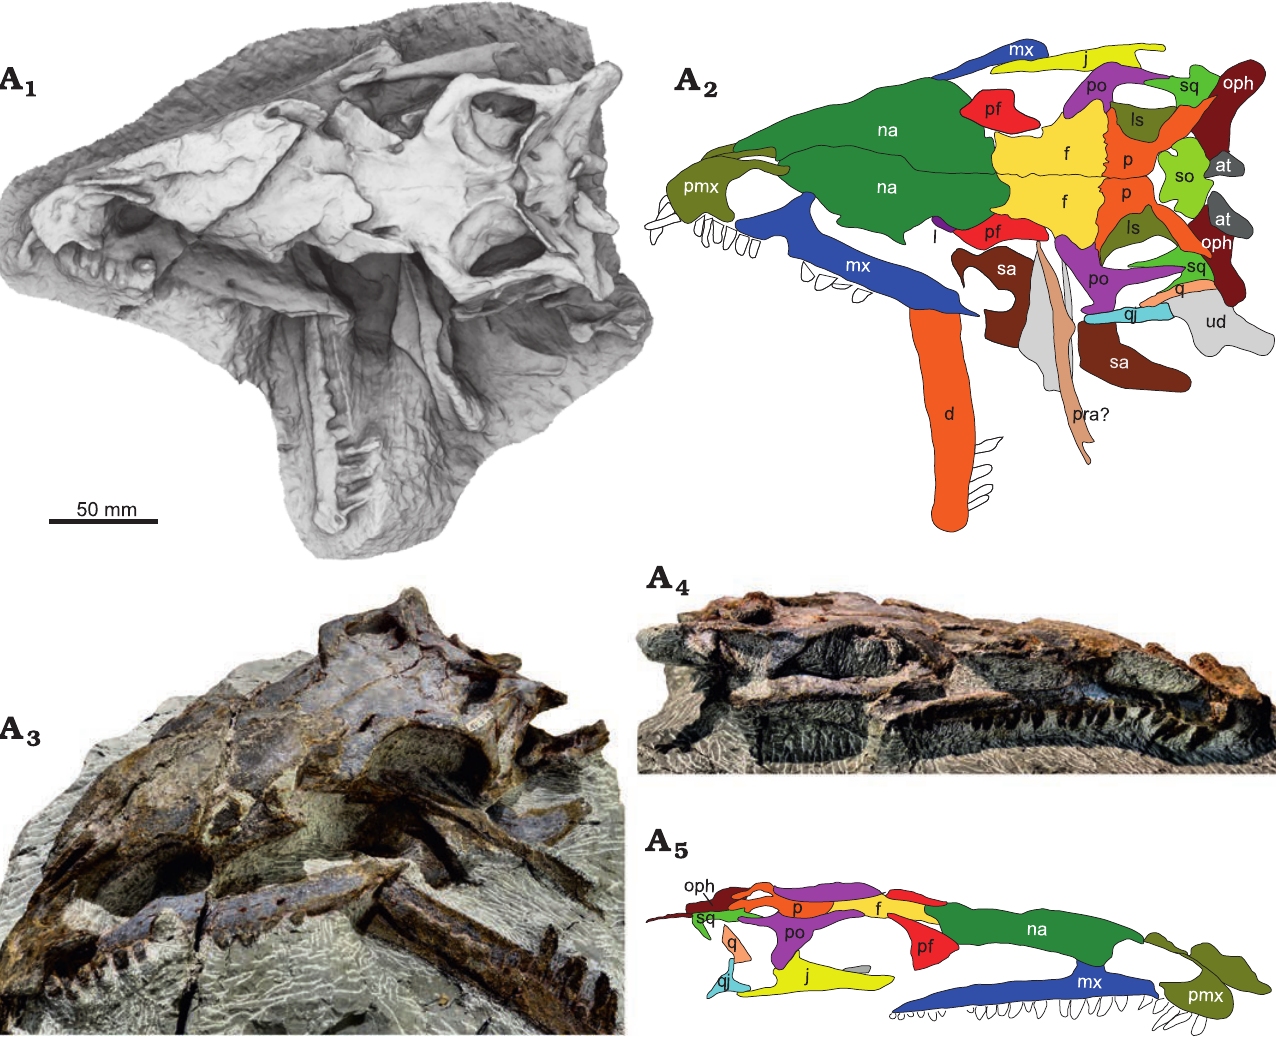
Fig. 8. A . Skull of the late-stage juvenile Plateosaurus trossingensis (MSF 12.3) from the Triassic of Frick, Switzerland. Ambient occlusion of pho - togrammetric model in dorsal view (A 1 ) and interpretative diagram (A 2 ); photograph of the skull in oblique view (A 3 ); photograph of the right lateral view (A 4 ) and interpretative diagram (A 5 ). Abbreviations: at, atlas; d, dentary; f, frontal; j, jugal; l, lacrimal; ls, laterosphenoid; mx, maxilla; na, nasal; oph, opisthotic; p, parietal; pf, prefrontal; pmx, premaxilla; po, postorbital; pra, prearticular; q, quadrate; qj, quadratojugal; sa, surangular; so, supraoccipi- tal; sq, squamosal; ud,